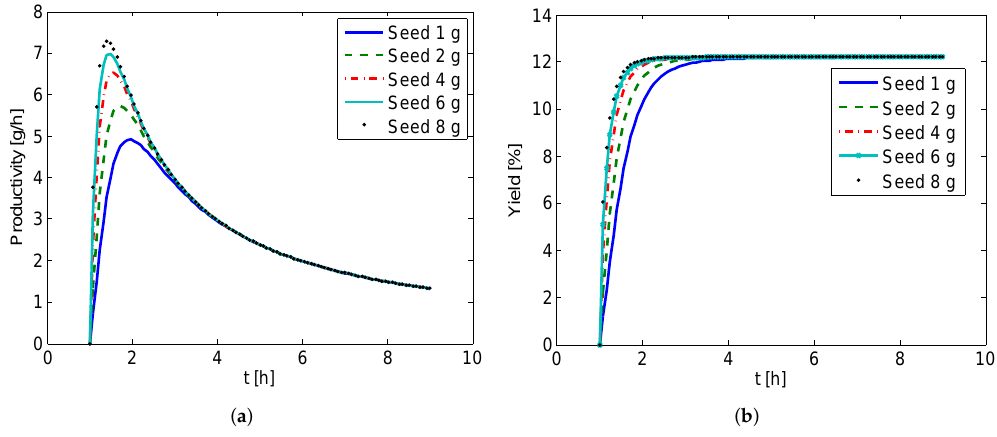
Figure 8. Simulation results showing the effect of seed mass on the productivity and yield of the coupled preferential crystallization (CPC) configuration (exchange rate 80 mL min − 1 ). Final productivity and yield are not affected by seed mass. ( a ) Productivity evolution; ( b ) Yield